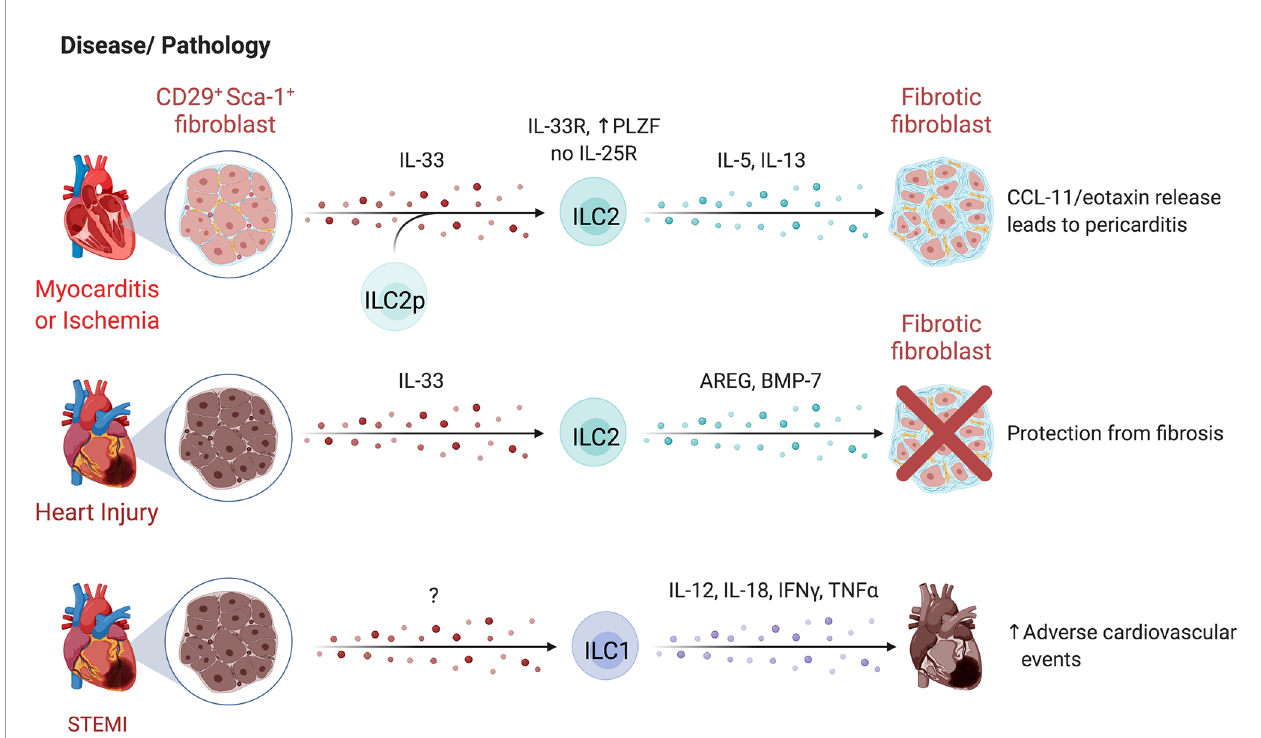
FIGURE 10 | ILCs in the heart. Limited studies have examined ILCs in the heart. In mice, IL-33 administration or CD27 + Sca-1 + fi broblast-derived IL-33 expands ILC2s in the pericardium, driving cardiac fi broblasts to secrete CCL-11/eotaxin, leading to the accumulation of eosinophils. In humans, CD127 + ILCs increase in the pericardial fl uid during in cardiac disease, particularly during pericarditis. Separately, the expansion of ILC2s by IL-33 was cardioprotective after injury, reducing fi brosis. Within 12 hours of acute ST-segment elevation myocardial infraction (STEMI), ILC1 elevation peaks. Higher ILC1-associated IL-12, IL-18, IFN- g , and TNF- a levels lead to a higher risk of major adverse cardiovascular events. Created with